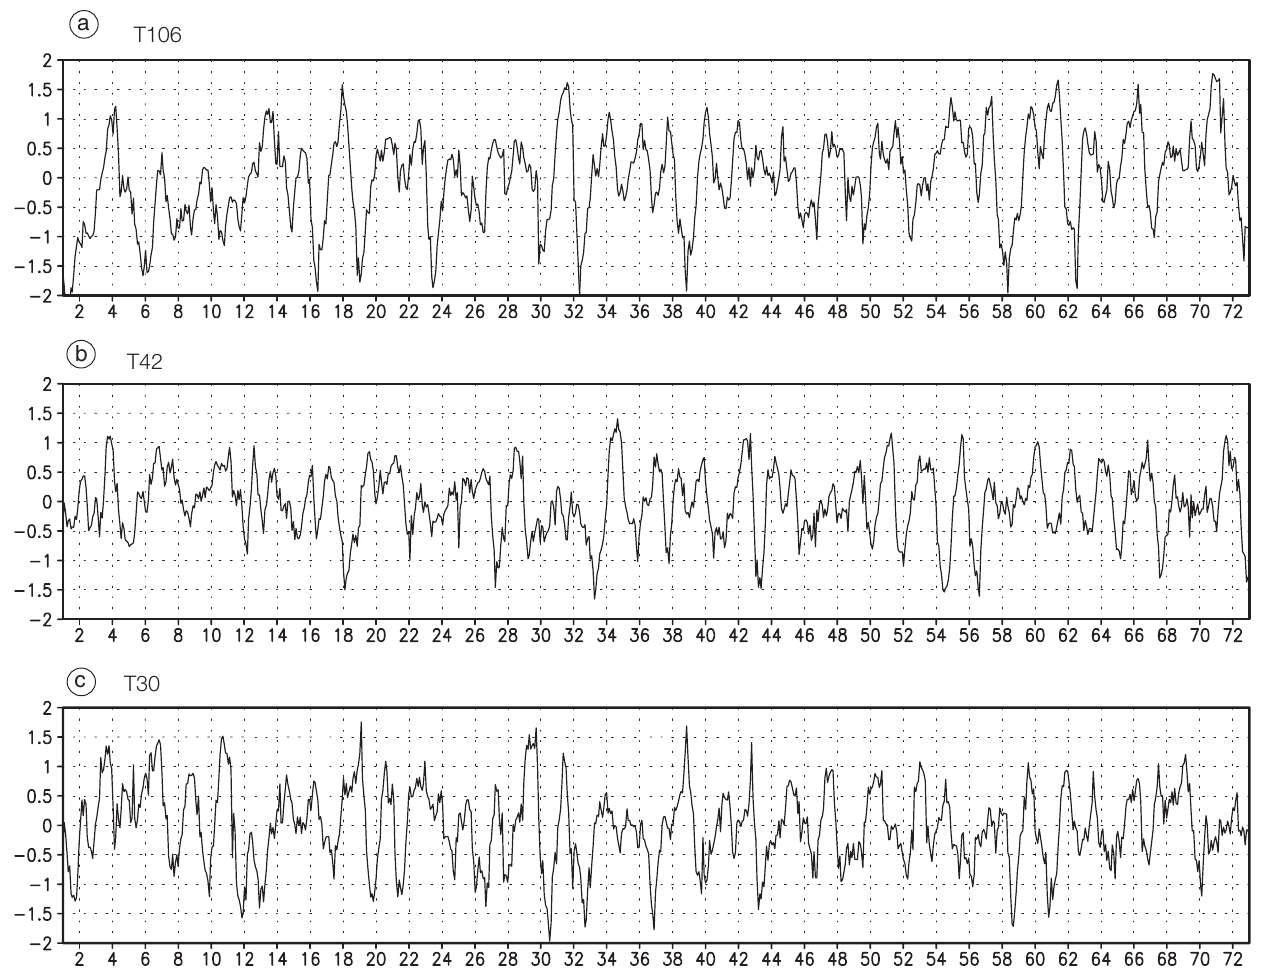
Fig. 11a-c. Time series of the SST anomaly averaged over the NIÑO-3 region (150 ° W-90 ° W, 5 ° S-5 ° N). The anomalies are computed with respect to the mean annual cycle. Panel a): T106 experiment; panel b): T42 experiment; panel c): T30